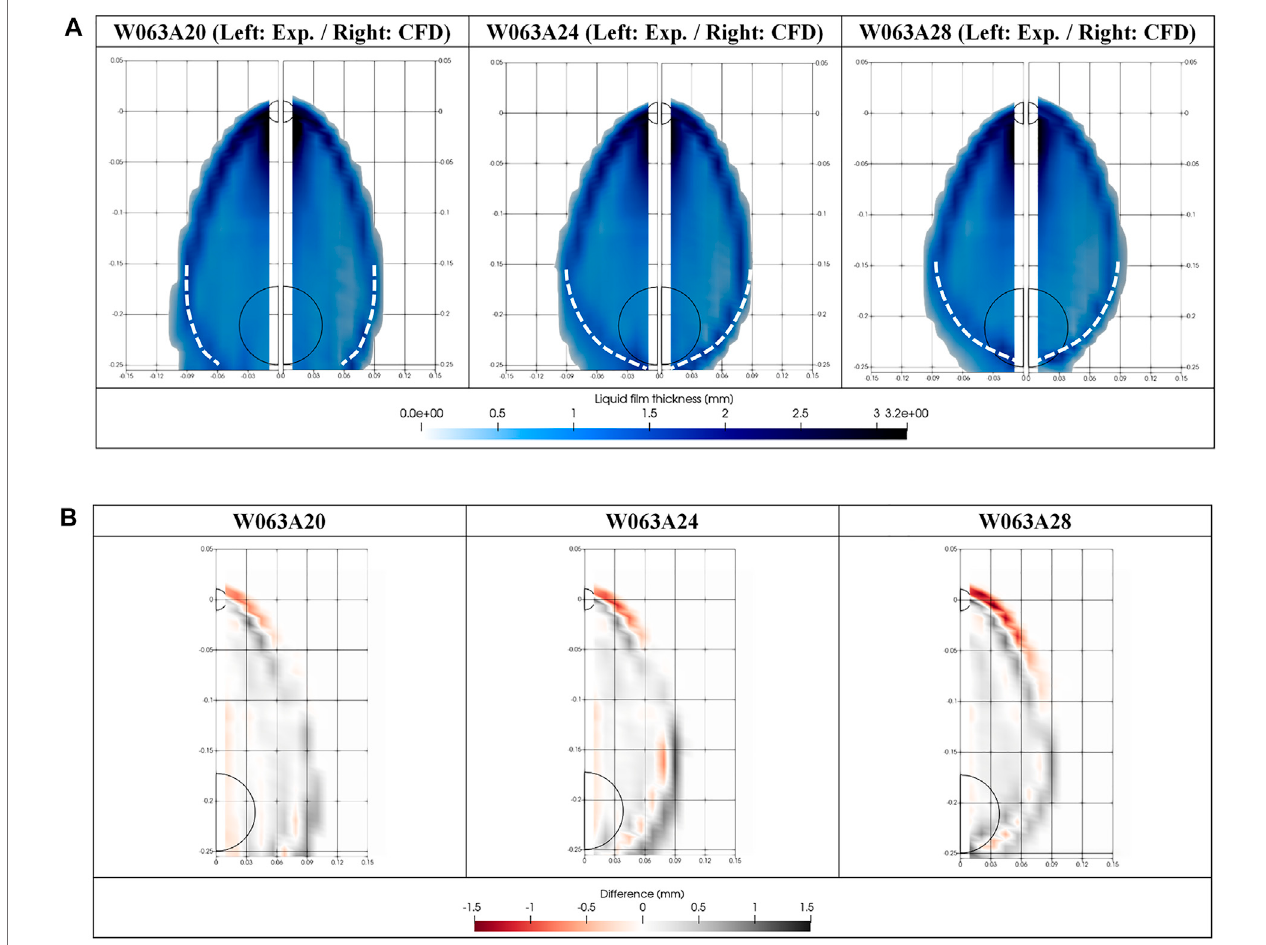
FIGURE 14 | (A) Comparison of liquid fi lm thicknesses. (B) Liquid fi lm thickness differences between the experiment and CFD.